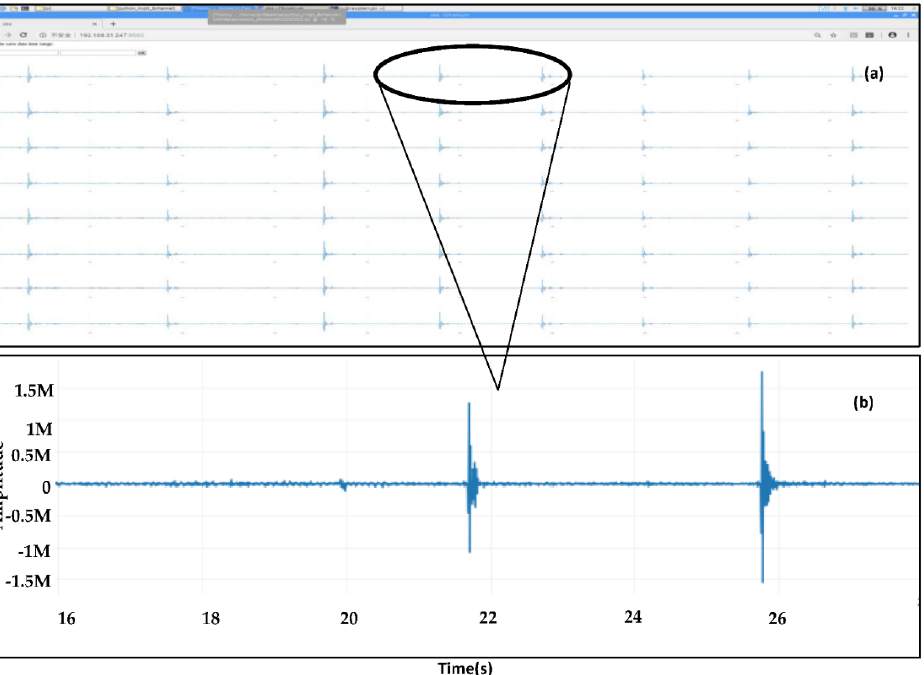
Figure 10. Screenshots from live streams of the seismic waveforms for the eight-channel seismograph running on the web browser of the Raspberry Pi. ( a ) Generated by banging. ( b ) A zoomed-in section of channel